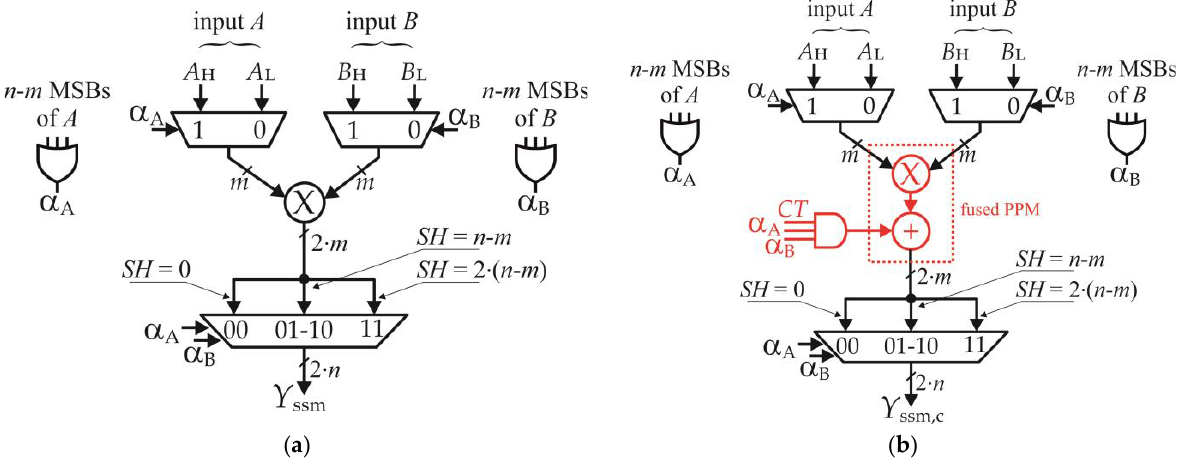
Figure 2. Approximate multiplier with ( a ) static segment method and ( b ) segmented multiplier with the correction technique of [30].